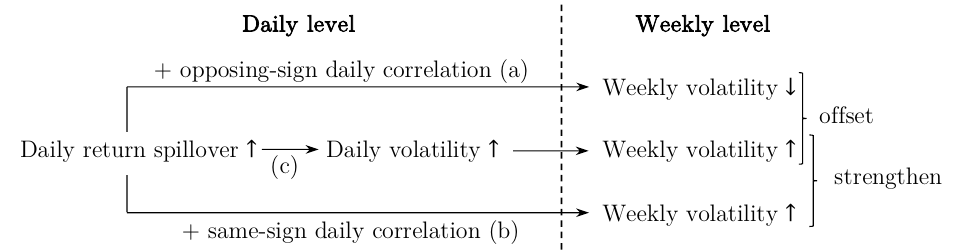
Figure 5. Channels of the links between daily return spillovers and asset’s weekly volatility. This figure illustrates the relationship between return spillovers, volatility and correlations of assets at the daily level and their volatility at the weekly level. We use “daily” and “weekly” for the illustration purpose; the results also apply to other relative “high” and “low”